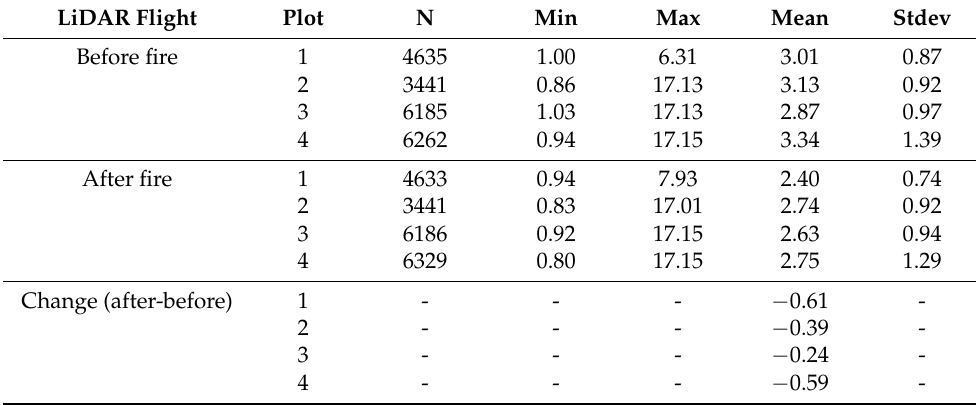
Table 1. Number of 0.5 × 0.5 m pixels (N), and the biomass (Mg ha − 1 ) minimum (Min), maximum (Max), Mean, standard deviation (Stdev), and change for each plot and flight. The before fire UAV LiDAR flight occurred on the 3/5/2018, and after the fire, it occurred on the 3/11/2018. Here, the dashed line (-) indicates that the change was not